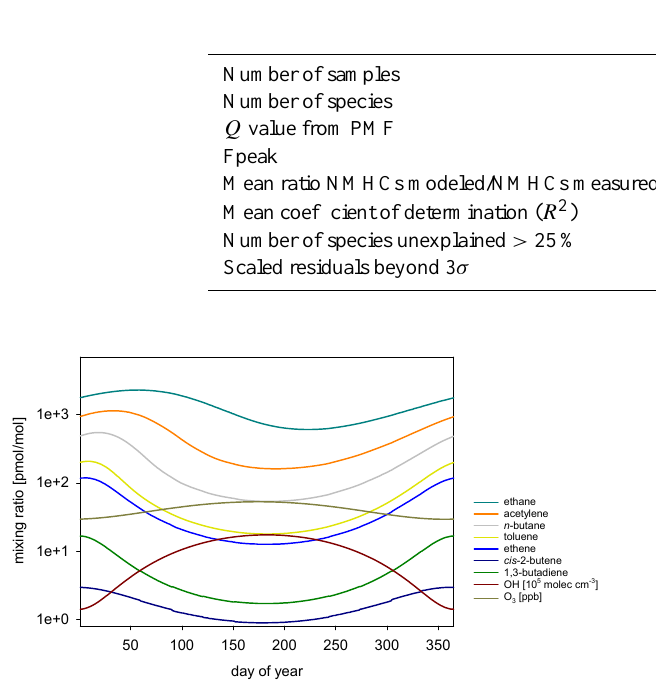
Figure 2. The calculated seasonal cycles of different NMHCs as- suming constant source of 5 × 10 3 moleccm − 3 s − 1 and the average annual cycles of OH and ozone as measured at